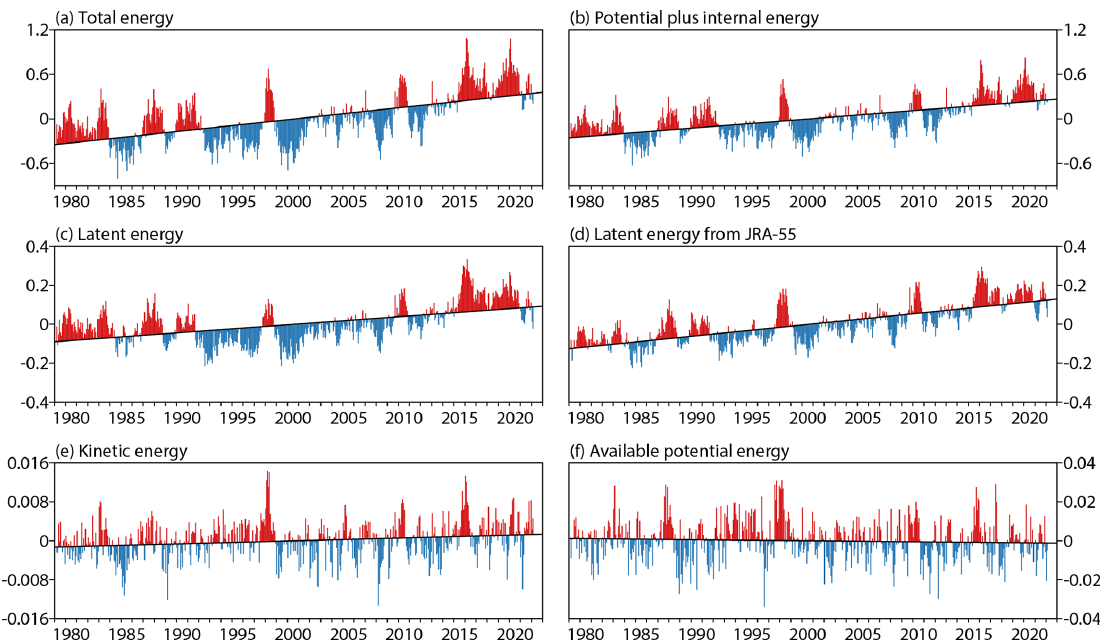
Figure 22. Monthly mean ERA5 global (a) total energy, (b) potential plus internal energy (TPE), (c) latent energy, (e) kinetic energy and (f) available potential energy (APE), expressed as average values per unit area of the Earth’s surface with unit 10 7 Jm − 2 , relative to the average for each month in the period from March 1979 to February 2022. Panel (d) shows latent energy from JRA-55. Values are plotted according to whether they are above (red) or below (blue) the least squares fit linear trend for this